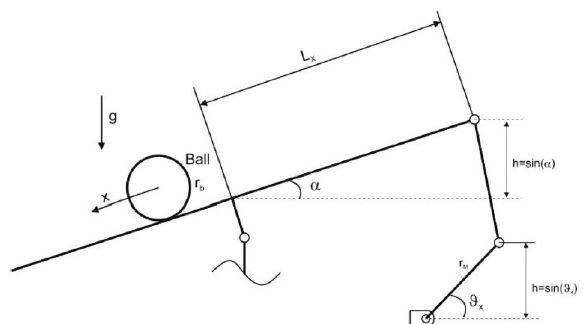
Fig. 3 Schematic diagram of ball and plate system [1]